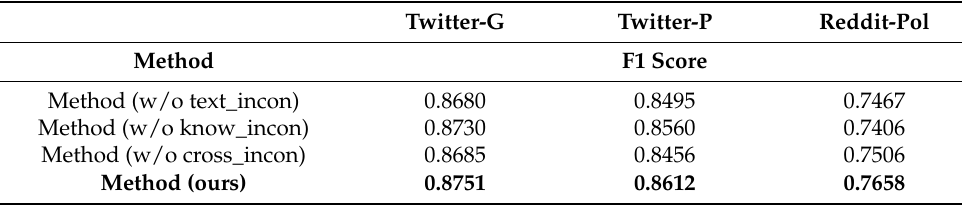
Table 5. Experimental results of the ablation study. The best result is in